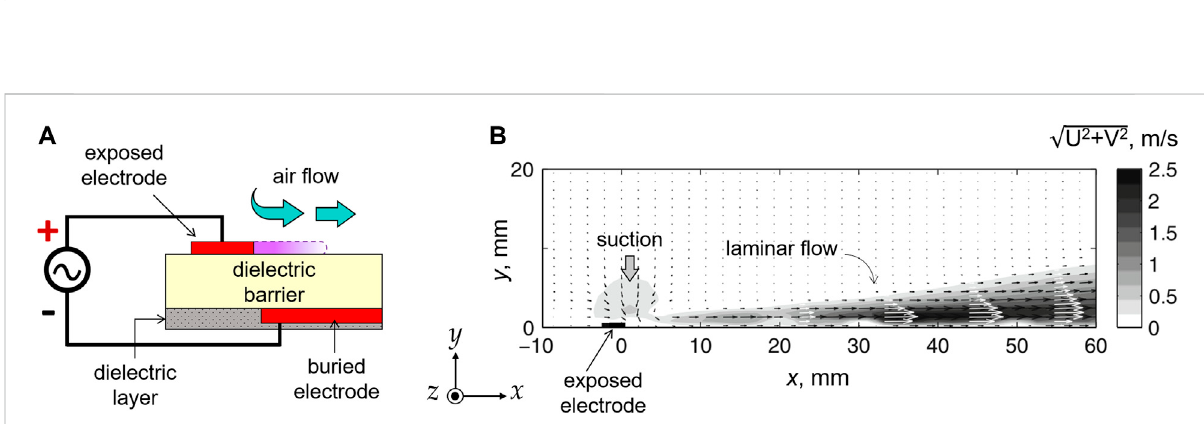
FIGURE 4 IllustrationoftheEHD force effect inSDBD. (A) Cross-sectional view ofan SDBD reactor inducing air fl owinthe x direction. (B) PIVphotograph of the air fl ow induced by a linear SDBD reactor in the x